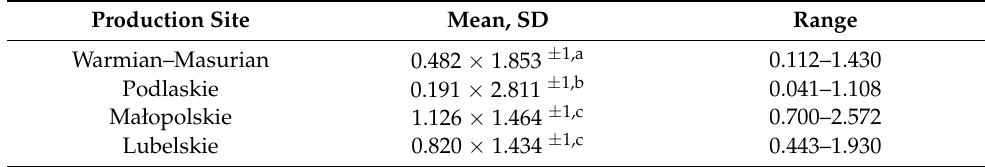
Table 3. Annual effective dose ( µ Sv/year) for 210 Po due to the ingestion of fruit wines from different